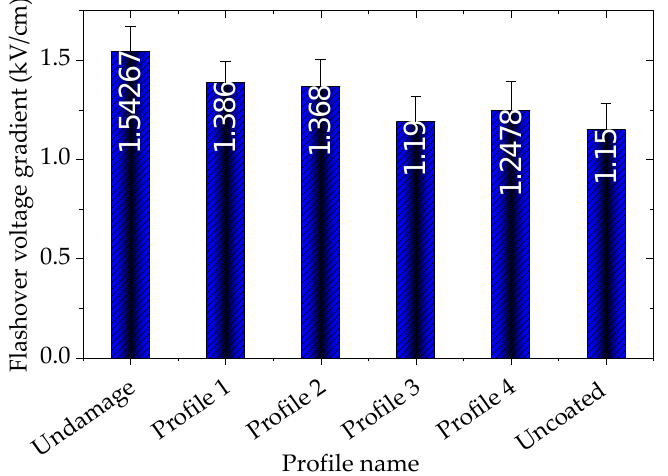
Figure 6. Flashover voltage gradient of clean insulator under different profile coating.